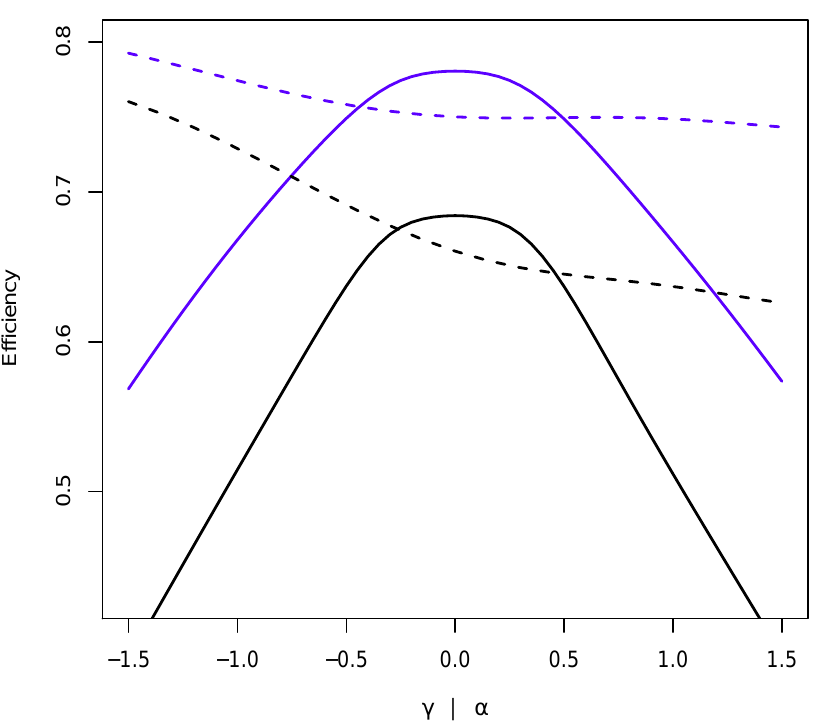
Figure 3. Efficiency of MD07 (blue) and MD10 (black) as a function of γ (solid) and of α (broken): x ∗ ∼ N ( 0 , I p − 1 ) , n = 5000, p = 5; the solid line is obtained with α = 1 and γ ∈ [ − 1.5,1.5 ] ; the broken line is obtained with γ = 0.5, and α ∈ [ − 1.5,1.5 ] . Table 2. Monte Carlo efficiencies (%) of the MDE and MCML estimators of the Poisson regression